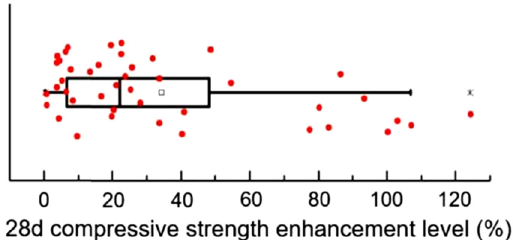
Figure 6: Distribution of GPC strength enhancement levels by di ff erent nanomaterials [ 26 ] .